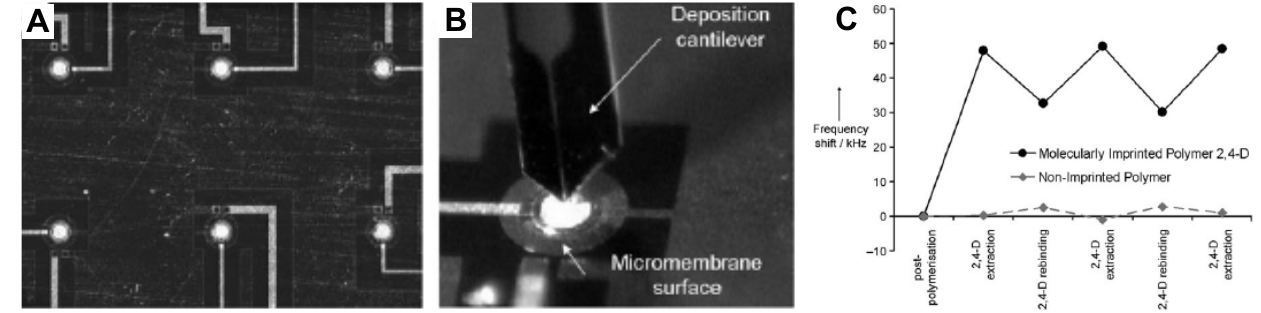
Figure 10. Image of (A) a matrix of piezoelectric micromembranes with a global radius of 100 µm and (B) a cantilever loaded with MIP precursor solution during deposition onto a micromembrane. (C) Reproducibility of resonance-frequency measurements for